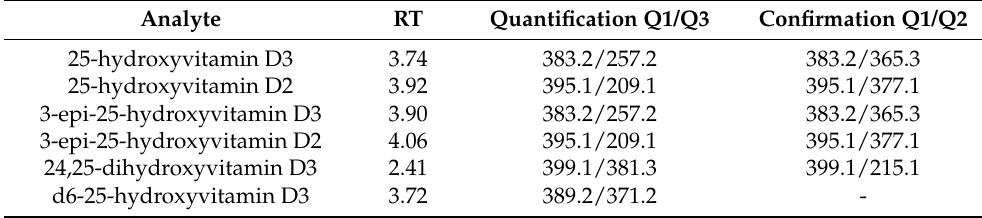
Table 2. Summary of retention times (RT) and selected MRM (multiple reaction monitoring)